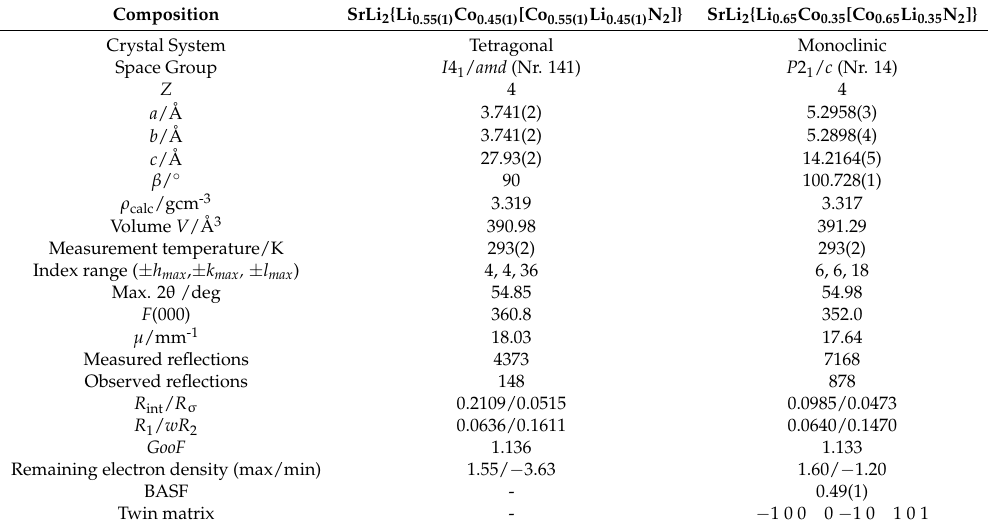
Table 1. Single crystal structural refinement of SrLi 2 {Li 1– x Co x [Co 1– x Li x N 2 ]} in the space groups